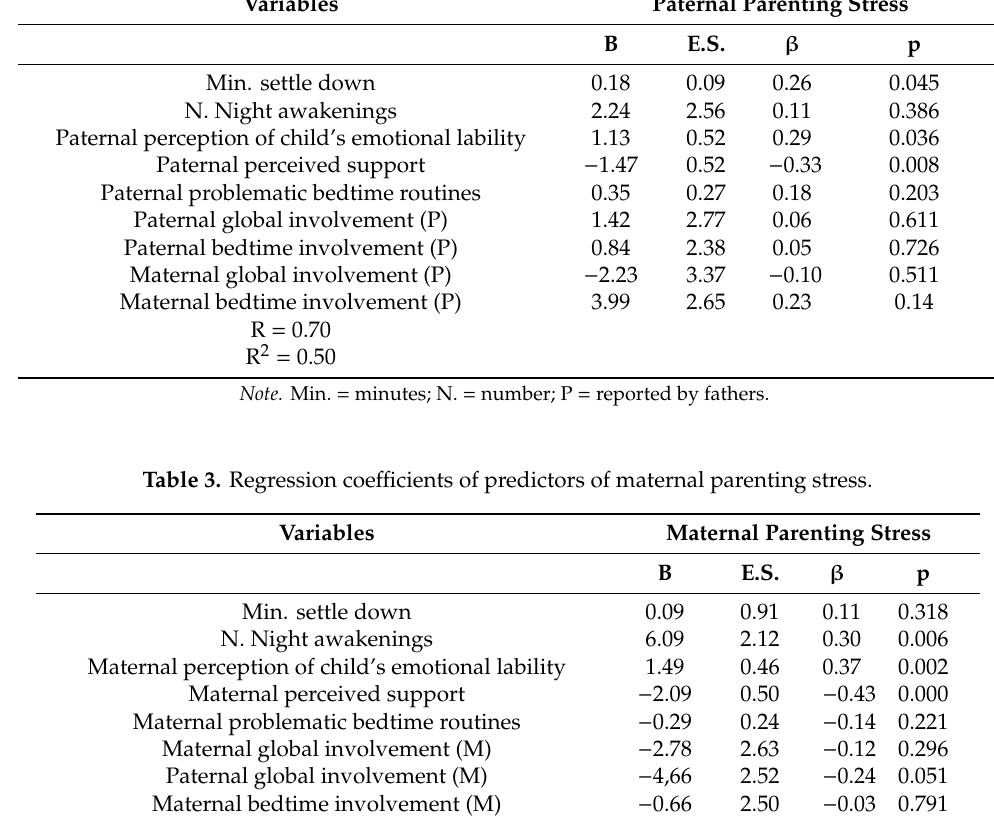
Maternal perceived support Maternal problematic bedtime routines Maternal global involvement (M)